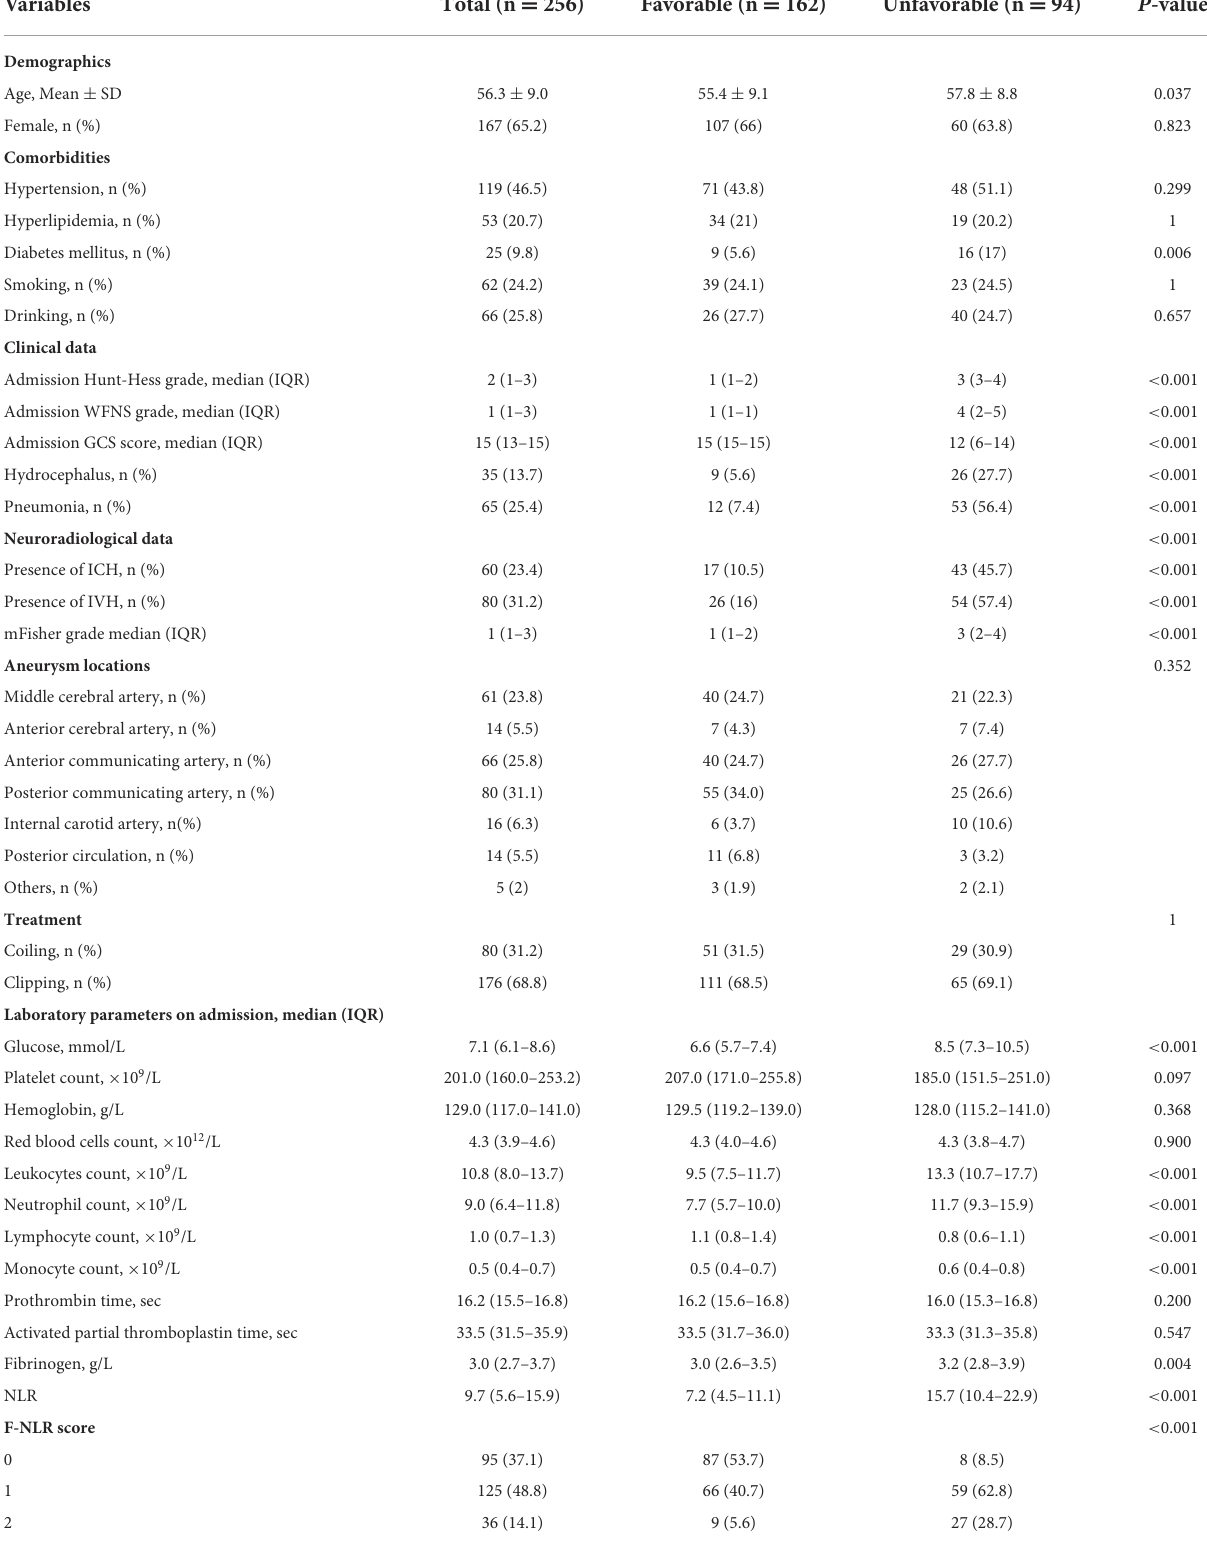
TABLE 1 Comparison of aSAH patients according to 3-month functional